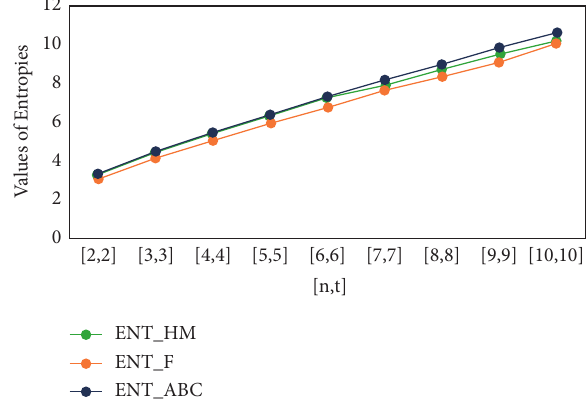
Figure 4: Comparison of entropies for corona product of hypertree and a path CBT ( t ) ⊙ P n